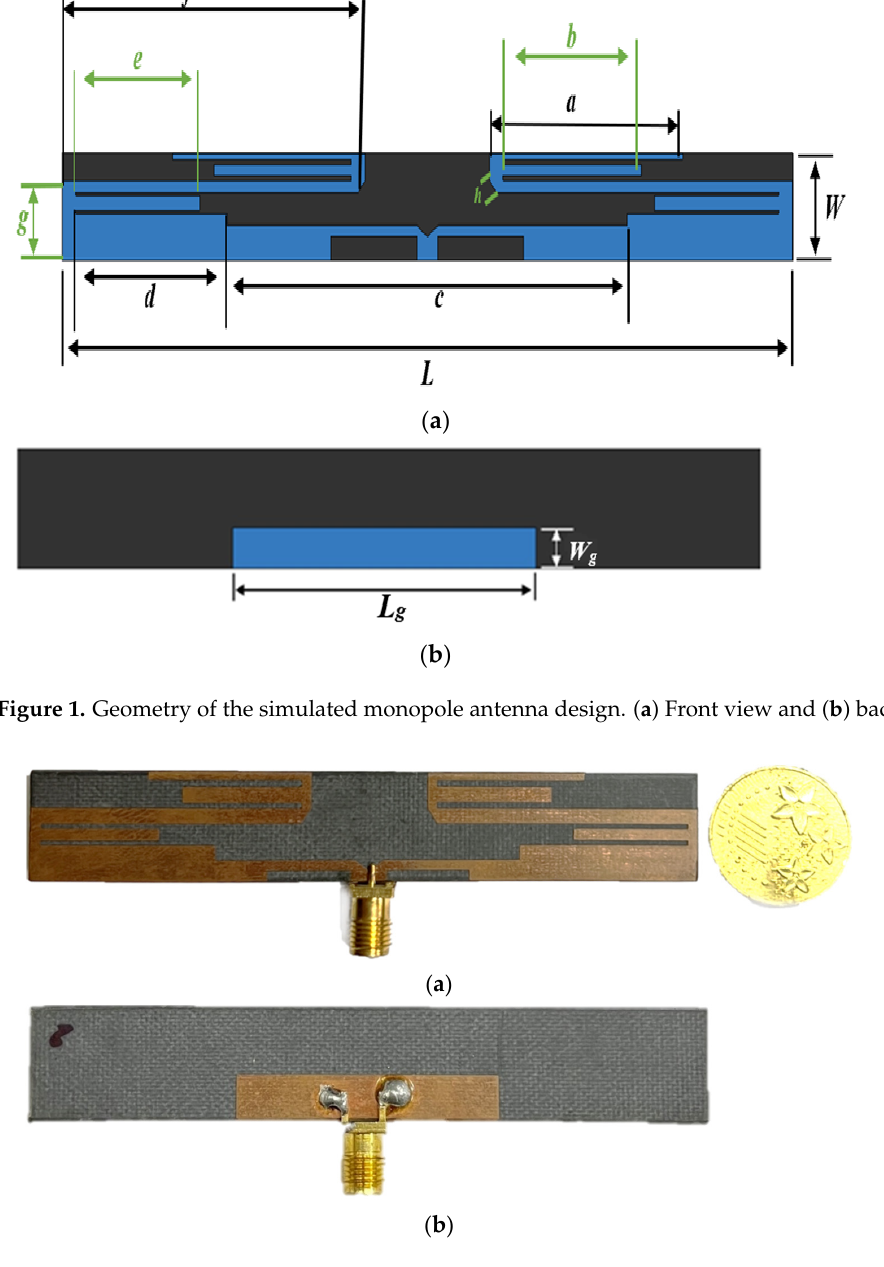
Table 2. Optimised dimensions of the proposed monopole